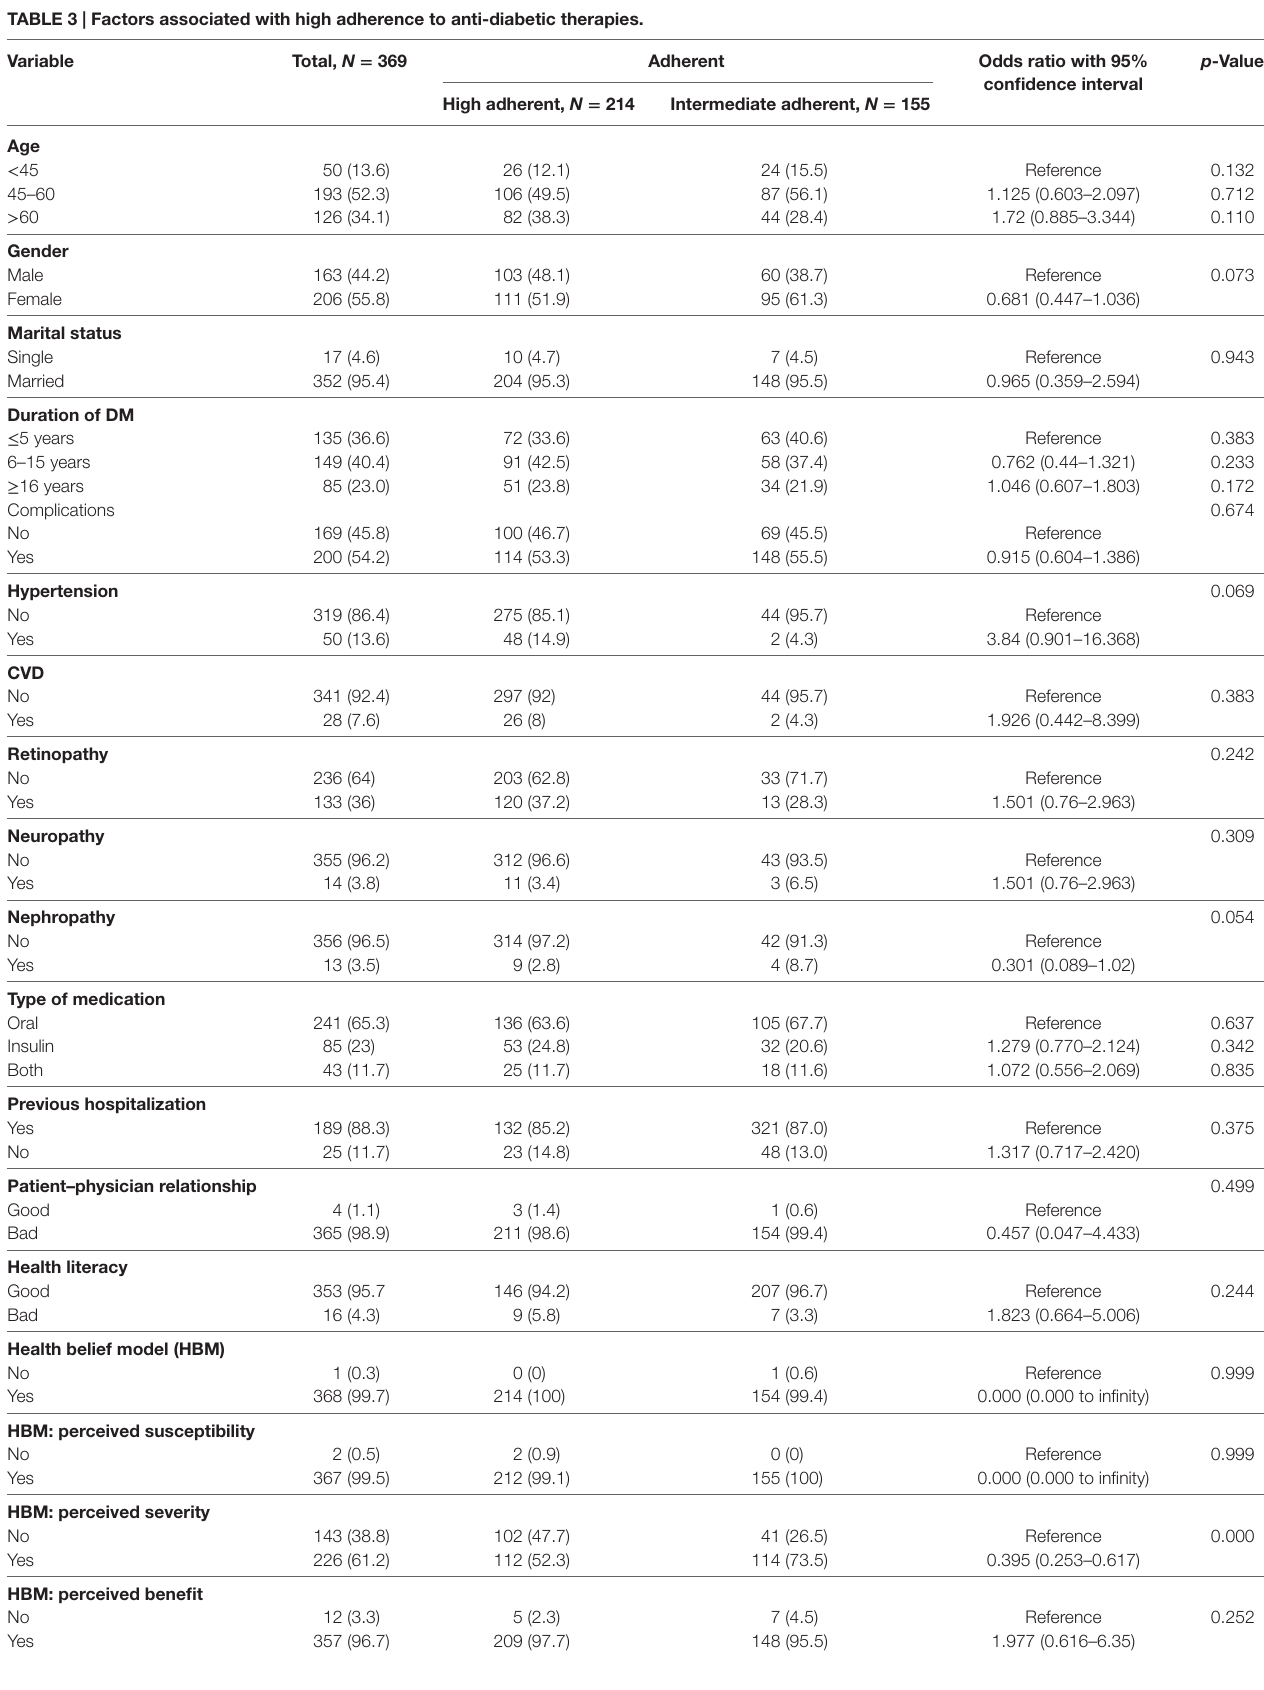
Table 3 | Factors associated with high adherence to anti-diabetic